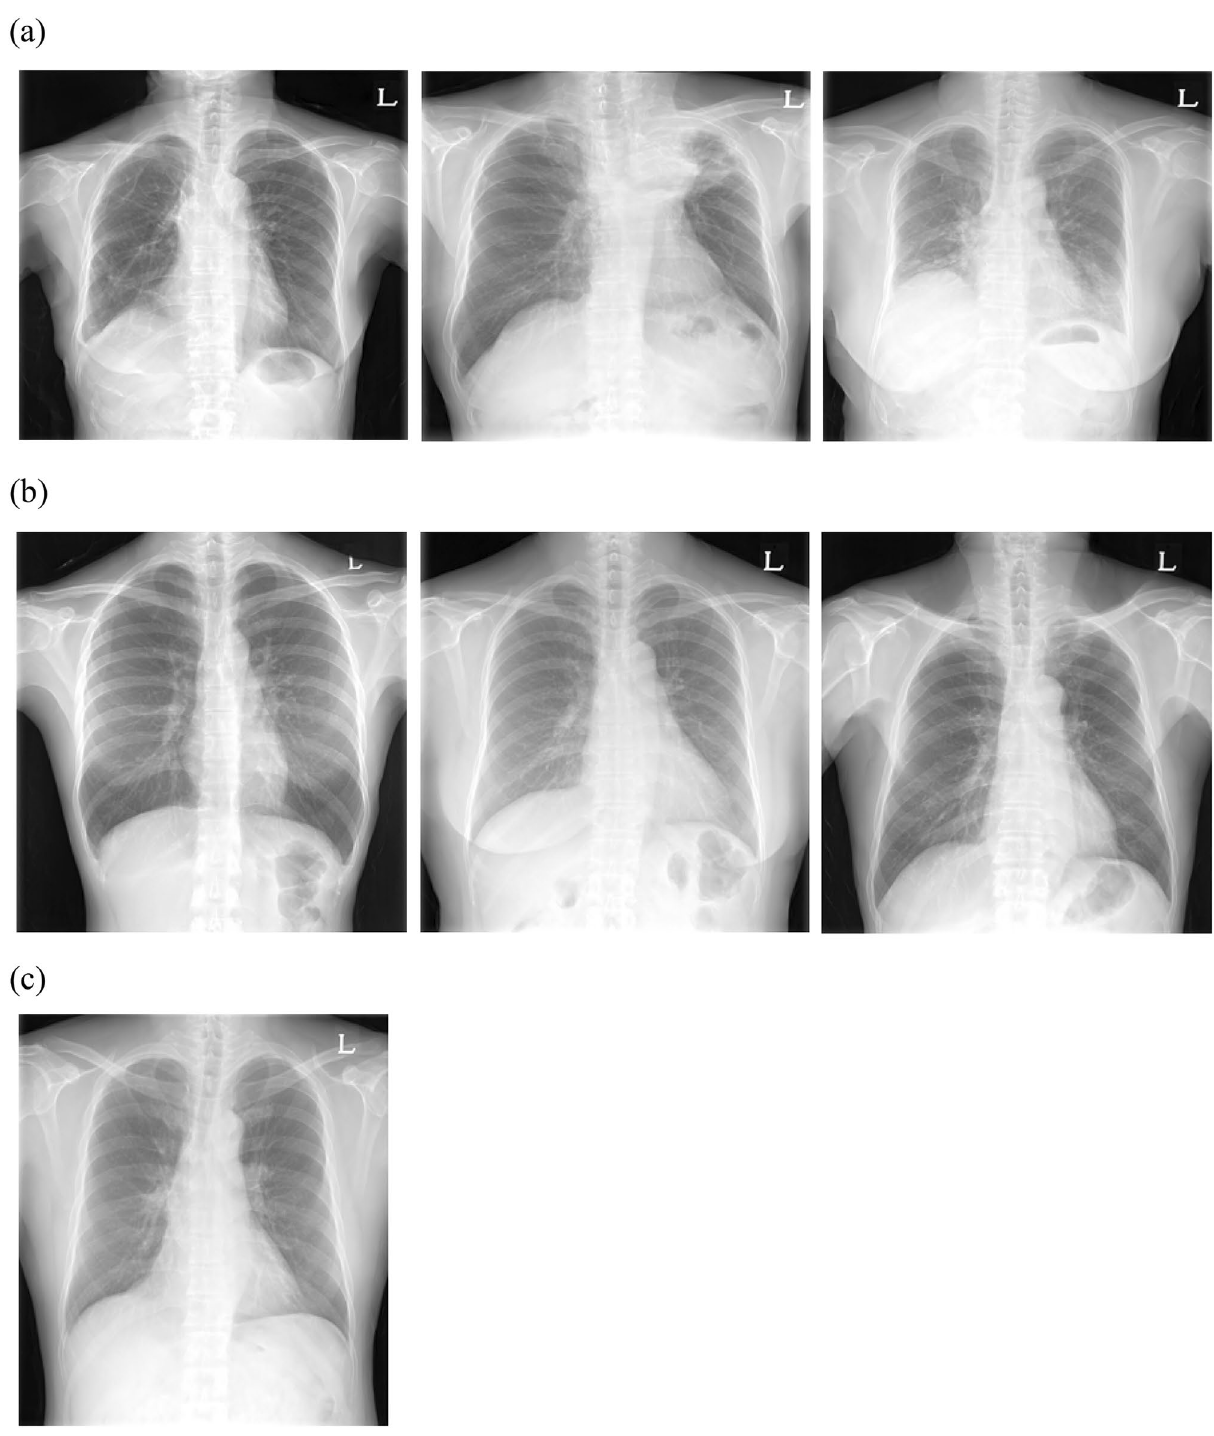
Figure 1. Several cases of the Turing test. ( a ) Synthetic images wherein the decisions of all the readers are synthetic in the first Turing test. ( b ) Synthetic images wherein the decisions of all the readers are synthetic in the second Turing test. ( c ) Synthetic images wherein the decisions of all the readers are real in the first Turing